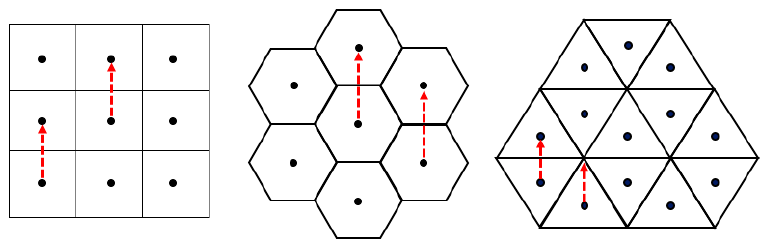
Figure 1. The square, hexagonal and triangular grids. Midpoints of the pixels represent their gridpoints. Any grid-vector translates the square and hexagonal grids to themselves, respectively. However, it is not the case in the triangular grid.